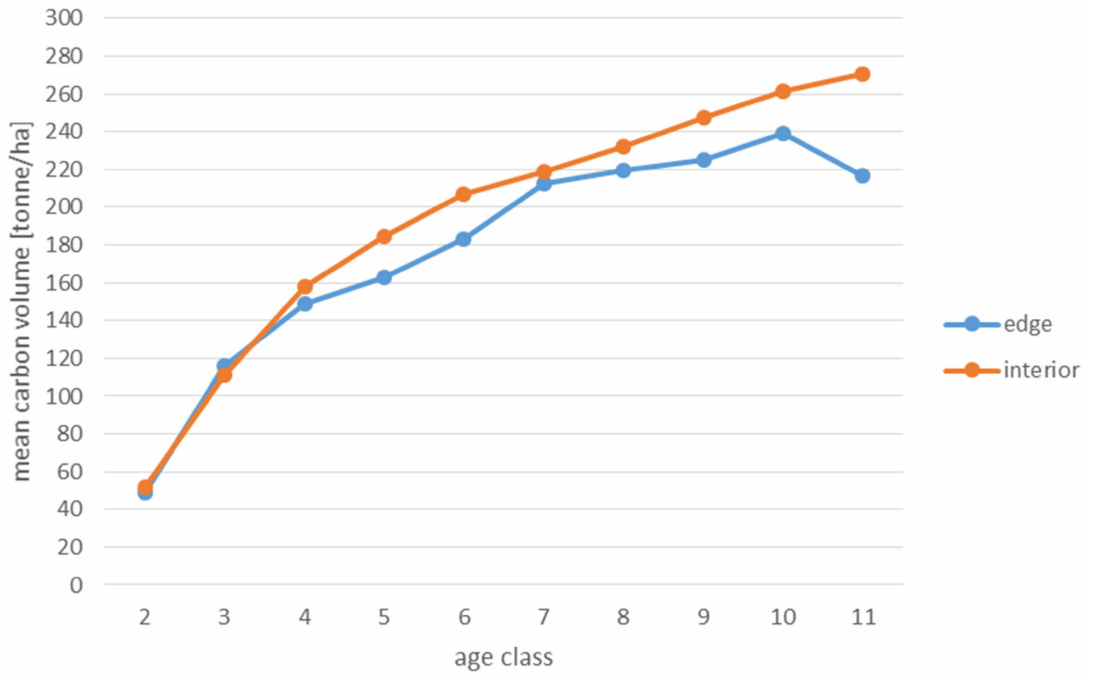
Figure 8. Changes in the mean carbon volume density in the site of FMBF, divided into the edge and interior